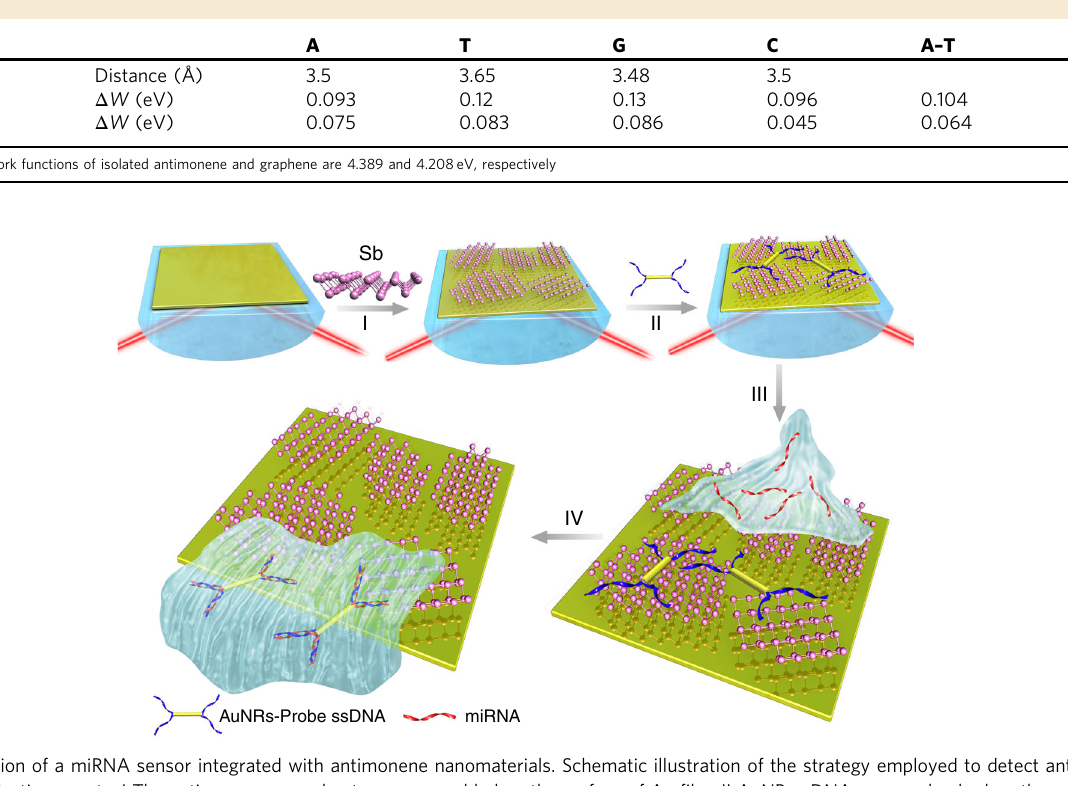
Table 1 Calculated vertical distance (Å) and work function change ( Δ W ) of antimonene and graphene with nucleobases and base-pairs